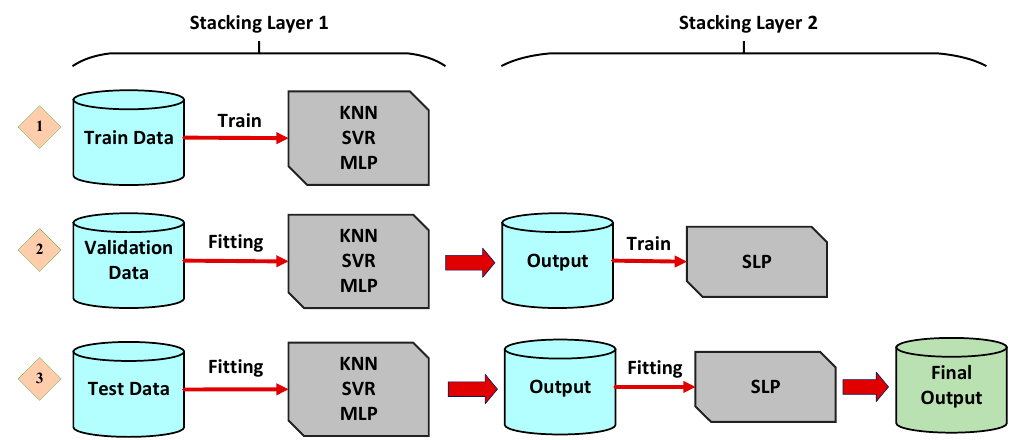
Figure 3. The data division for the training and testing of the stacking algorithm .